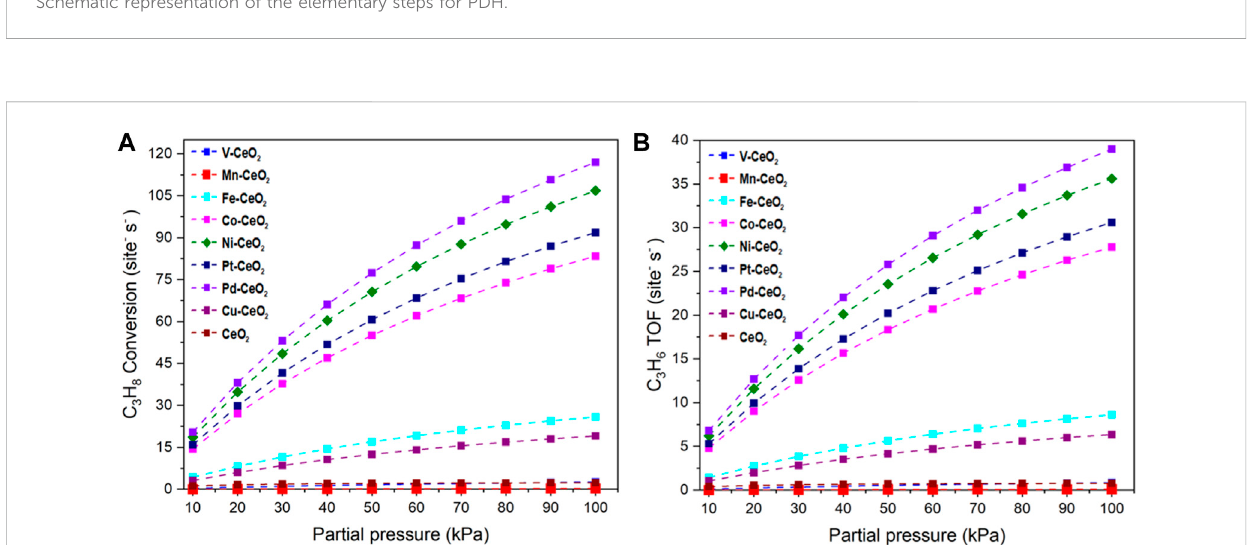
SCHEME 1 Schematic representation of the elementary steps for